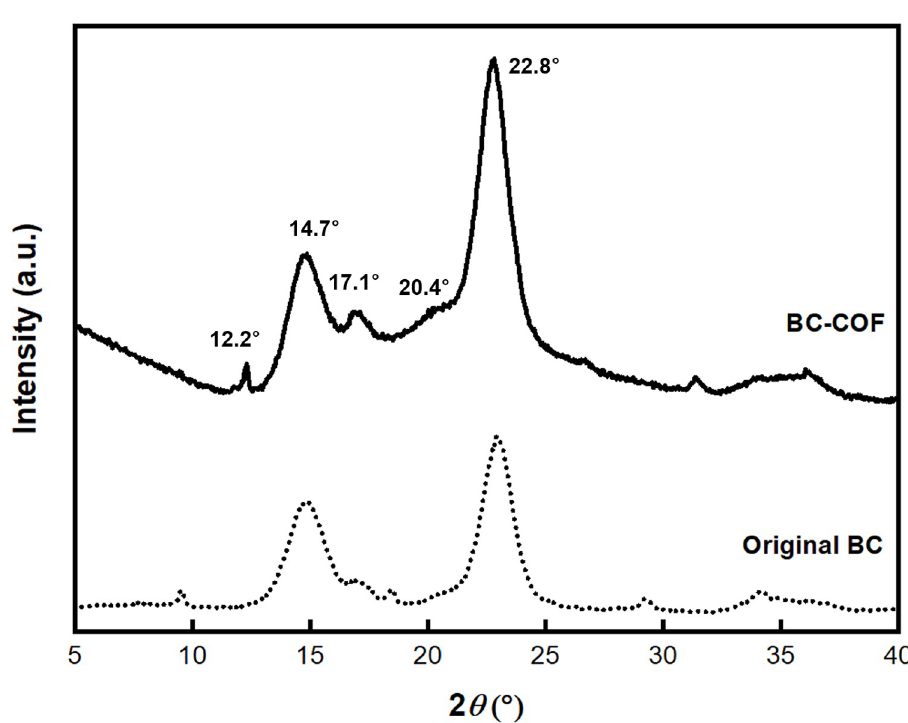
Fig 6. XRD diffraction patterns of original BC and BC-COF bio-leather (Extraction conditions: Liquor ratio of 1:10 (w/v), coffee at an amount of 200 wt% BC, 90˚C, 1 h; dyeing conditions: Fabric-to-liquor ratio of 1:10 (w/v), 70˚C, 30 min, meta-mordanting with 1% of FeSO 4 ).